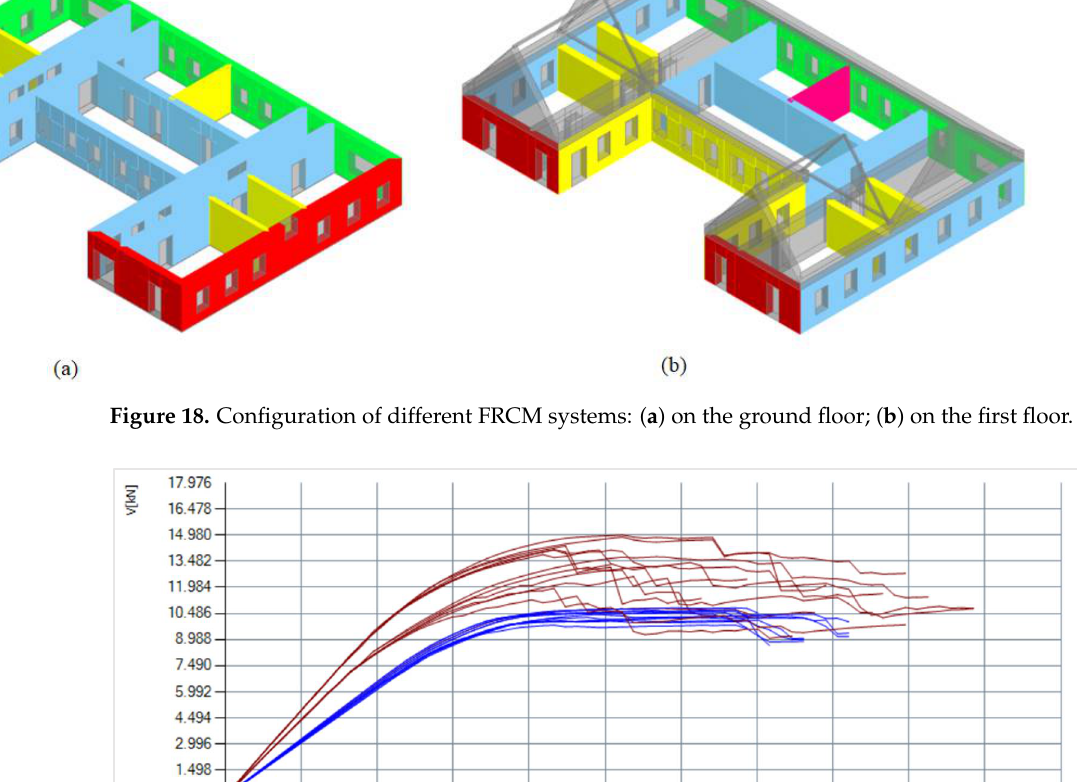
Table 6. FRP composite system properties.